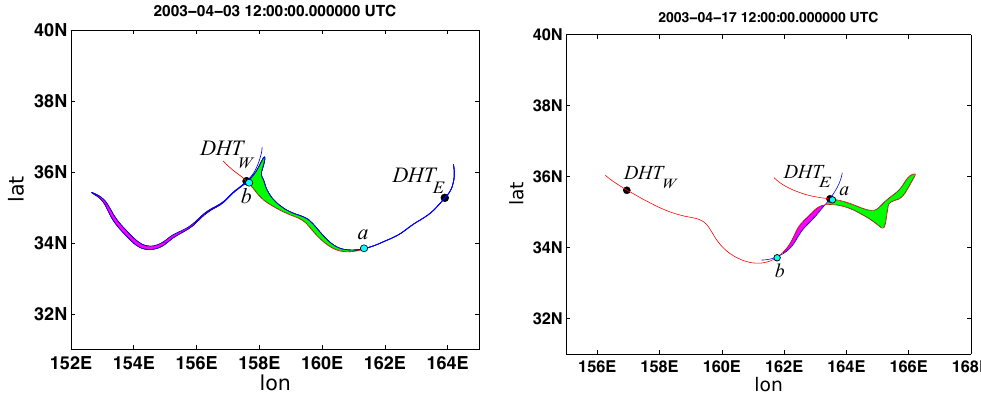
Fig. 7. Turnstile lobes at days April 3, 2003 and April 17, 2003. The intersection trajectories a and b are displayed at both days showing their evolution from the DHT W towards the DHT E . The green area evolves from north to south while the magenta area does from the south to the north.